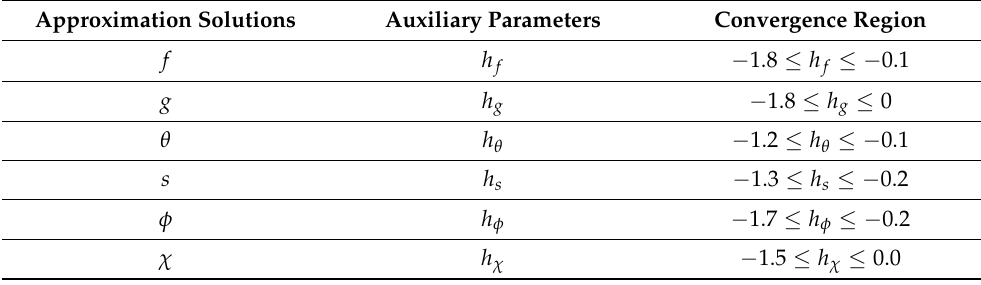
Table 1. Numerical evaluation for convergence region for h f , h g , h θ , h s , and h φ . Approximation